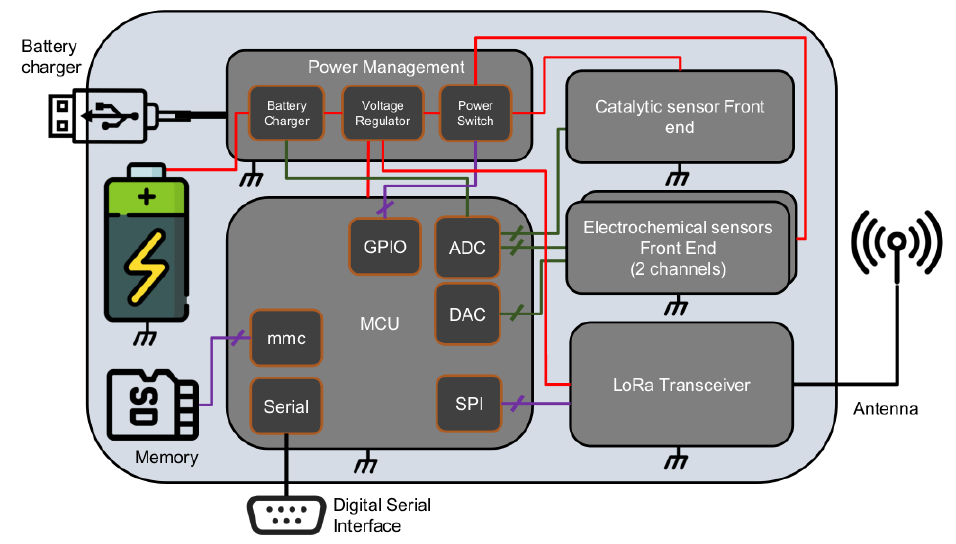
Figure 1. Sensor node architecture.